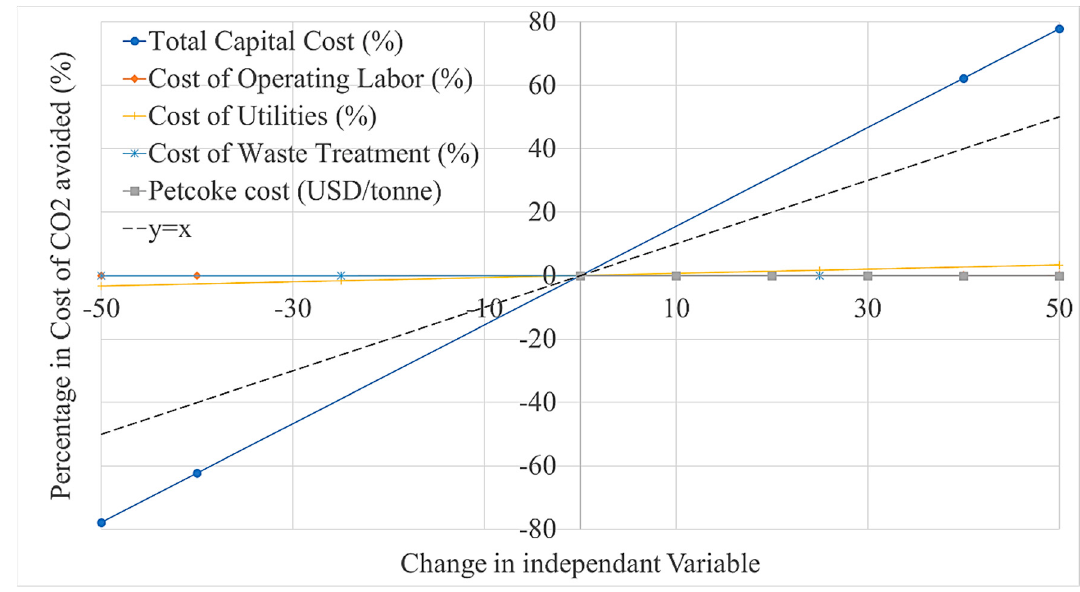
Figure 6. Sensitivity analysis for cost of CO 2 avoided in the USA.